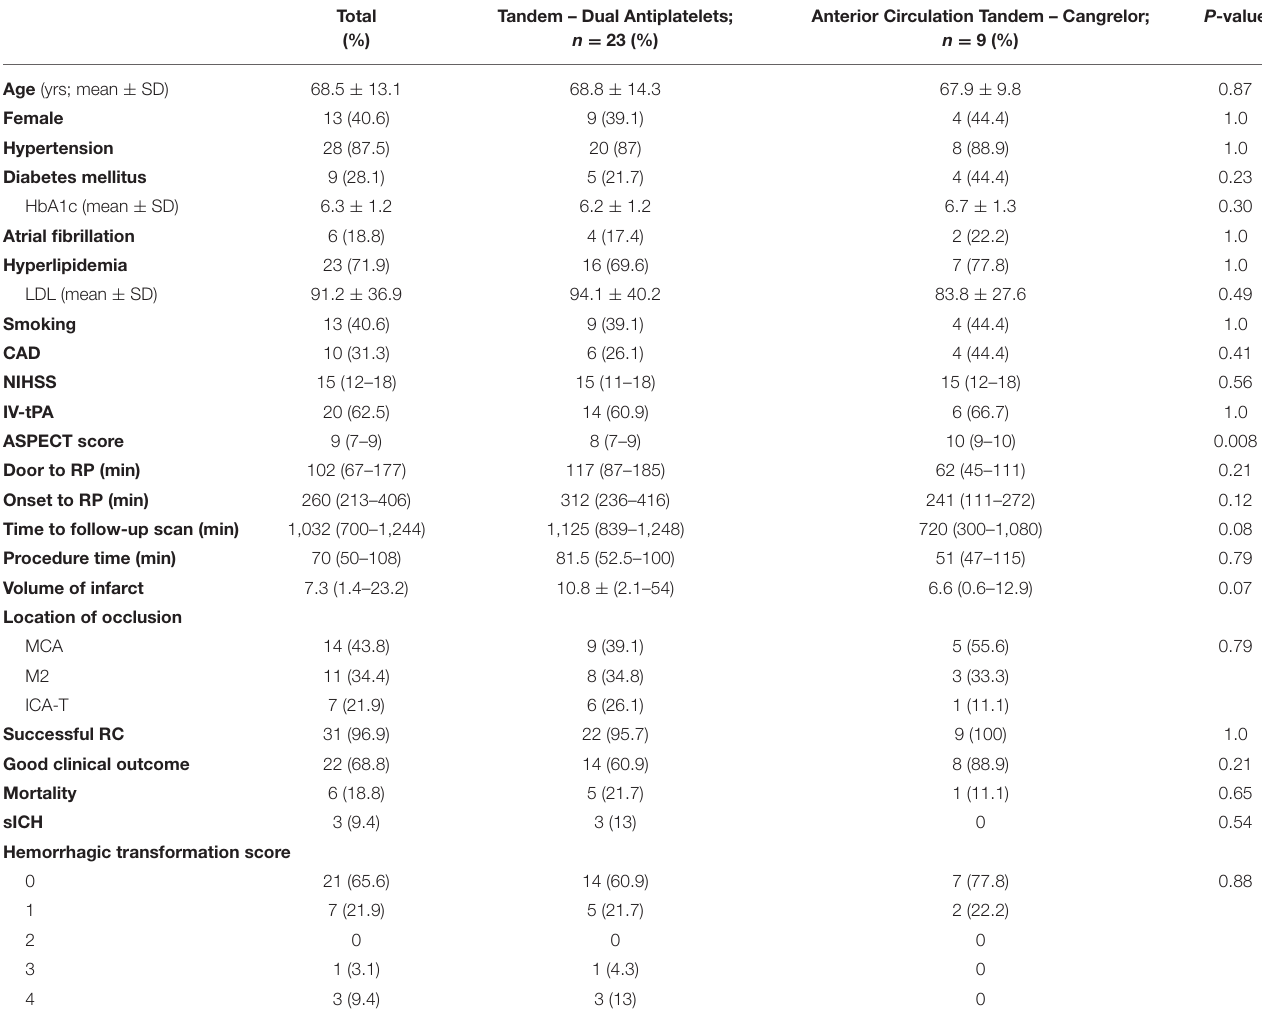
TABLE 3 | Anterior circulation tandem occlusions treated with acute administration of oral antiplatelets compared with those who were treated acutely with intravenous cangrelor.